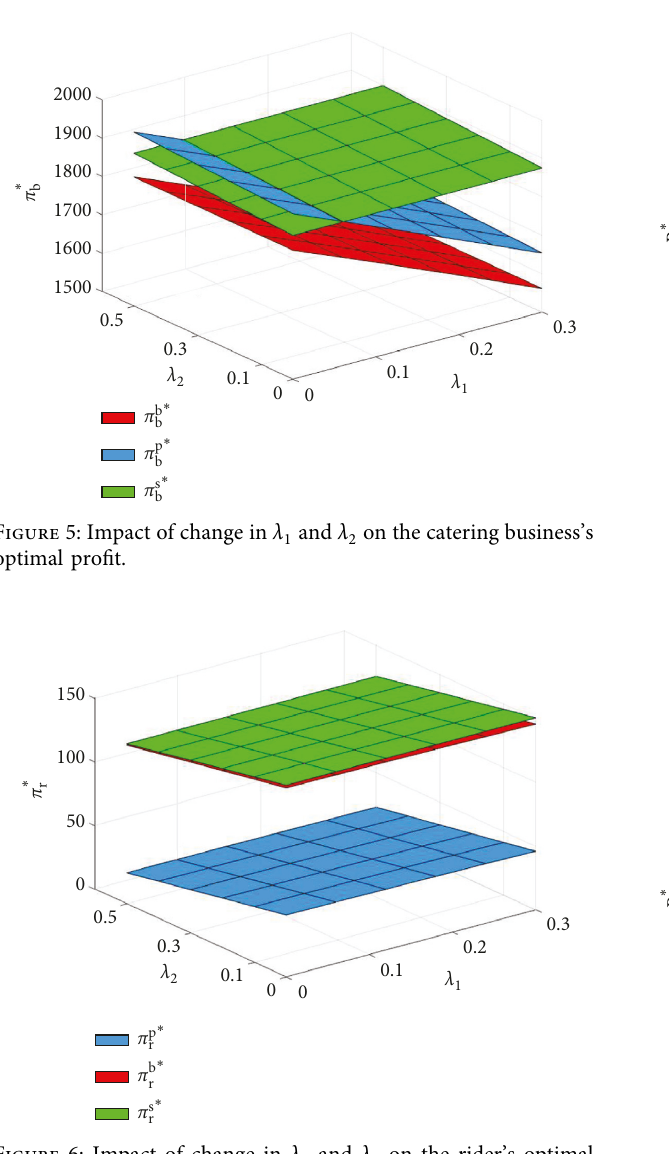
1 and λ 2 on the rider’s optimal